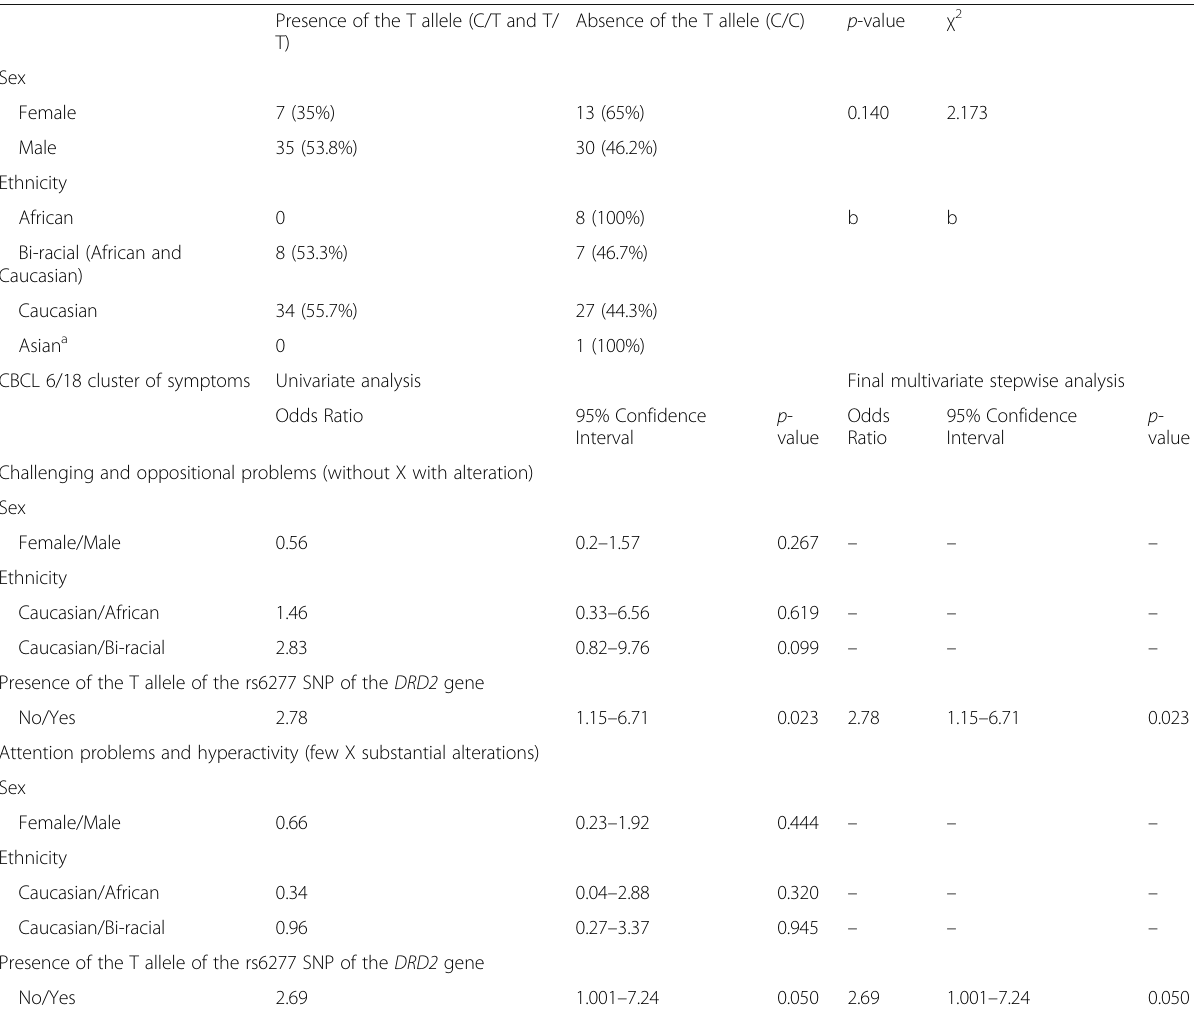
Table 4 Presence or absence of the T allele of the rs6277 polymorphism of the DRD2 gene, according to sex and ethnicity a , and logistic regression analyses Presence of the T allele (C/T and T/ Absence of the T allele T)